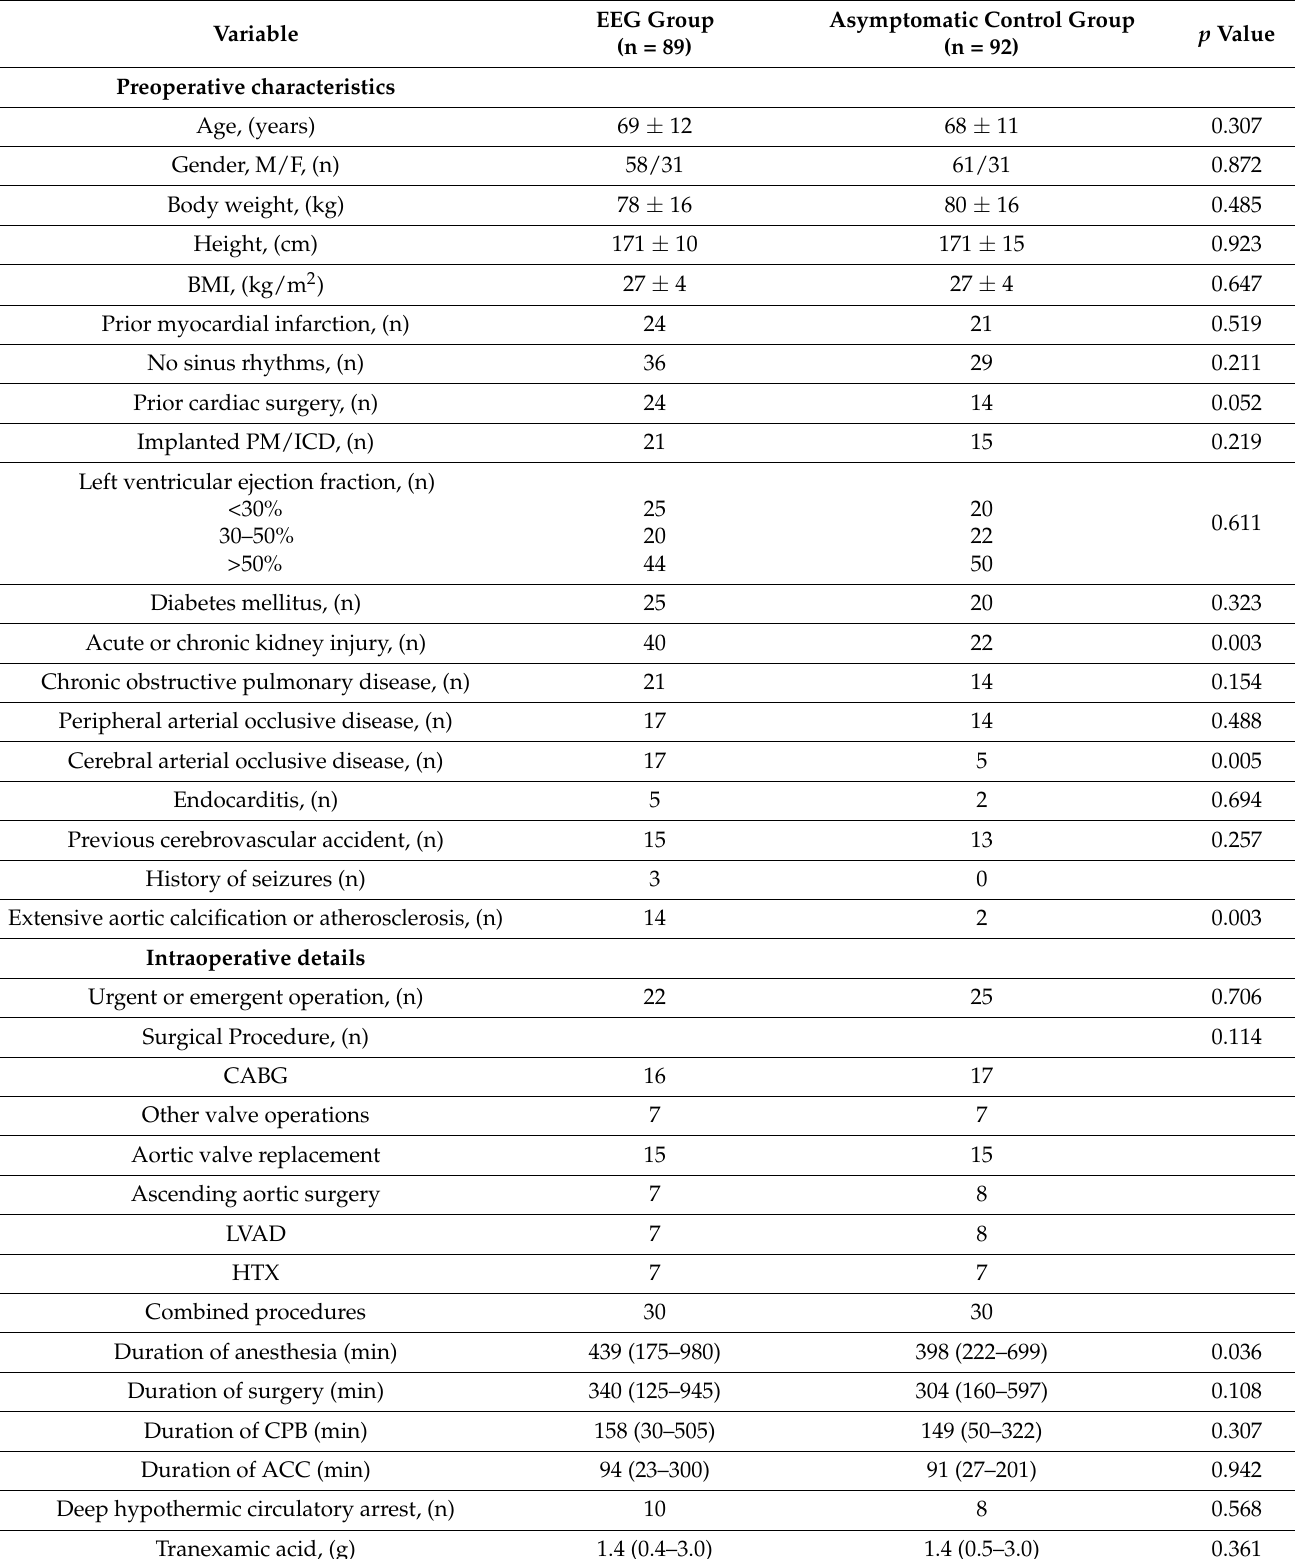
Table 1. Characteristics, intraoperative details and outcome data from patients with subsequent EEG studies and from neurologically asymptomatic